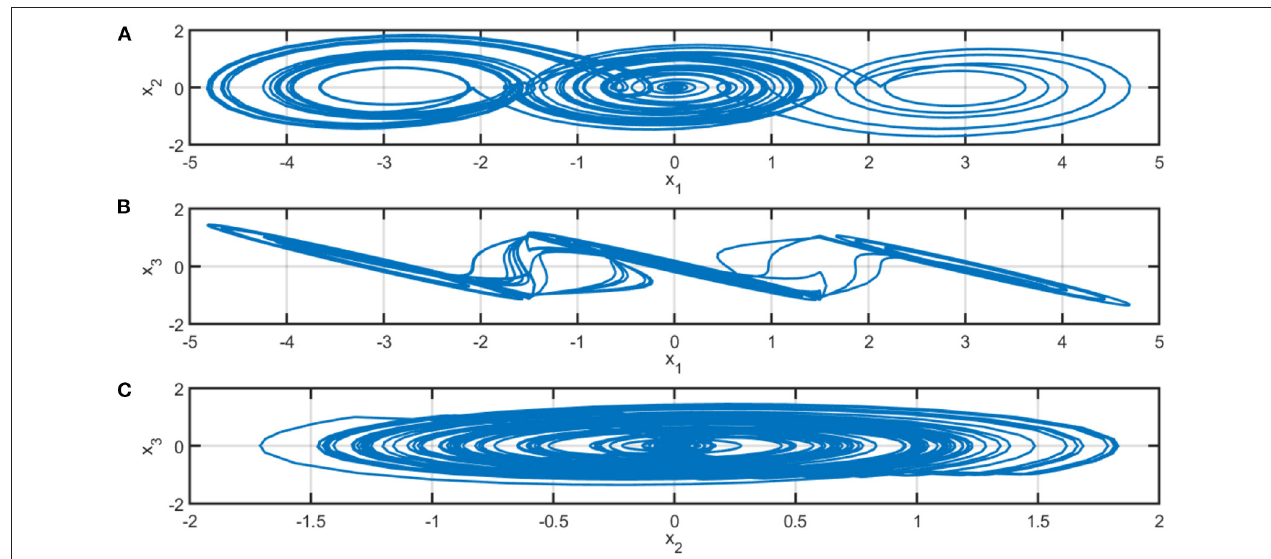
FIGURE 1 | Projections of the system given by equations. axplusbmethod and b3method onto the planes of R 3 . The plot (A) corresponds to x 1 x 2 plane; (B) is the projection onto x 1 x 3 plane; and (C) is the projection in x 2 x 3 plane.